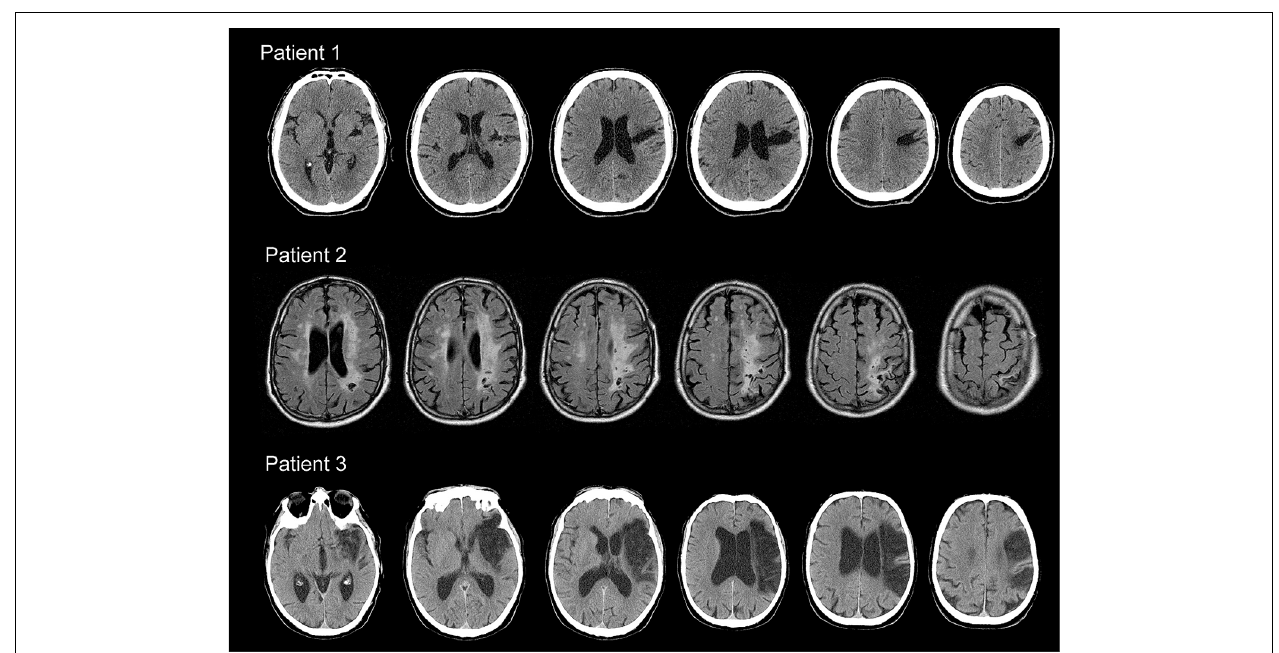
FIGURE 1 |Top: consecutive slices of CT scans for Patient 1 illustrating right frontal, temporal, and parietal lesions. Middle: consecutive MR slices of scans for Patient 2 showing damage to the right frontal, parietal, and